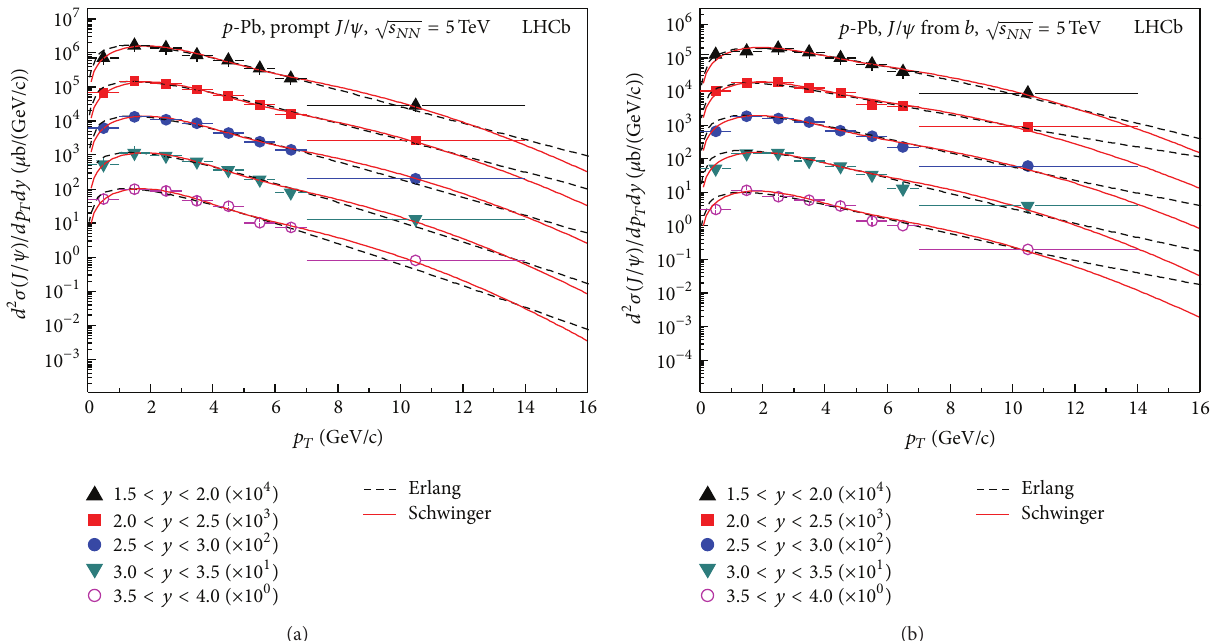
Figure 4: The same as Figure 2 but showing the results in different rapidity ranges in 𝑝 -Pb collisions at √𝑠 𝑁𝑁 = 5 TeV. The data are taken from [19].